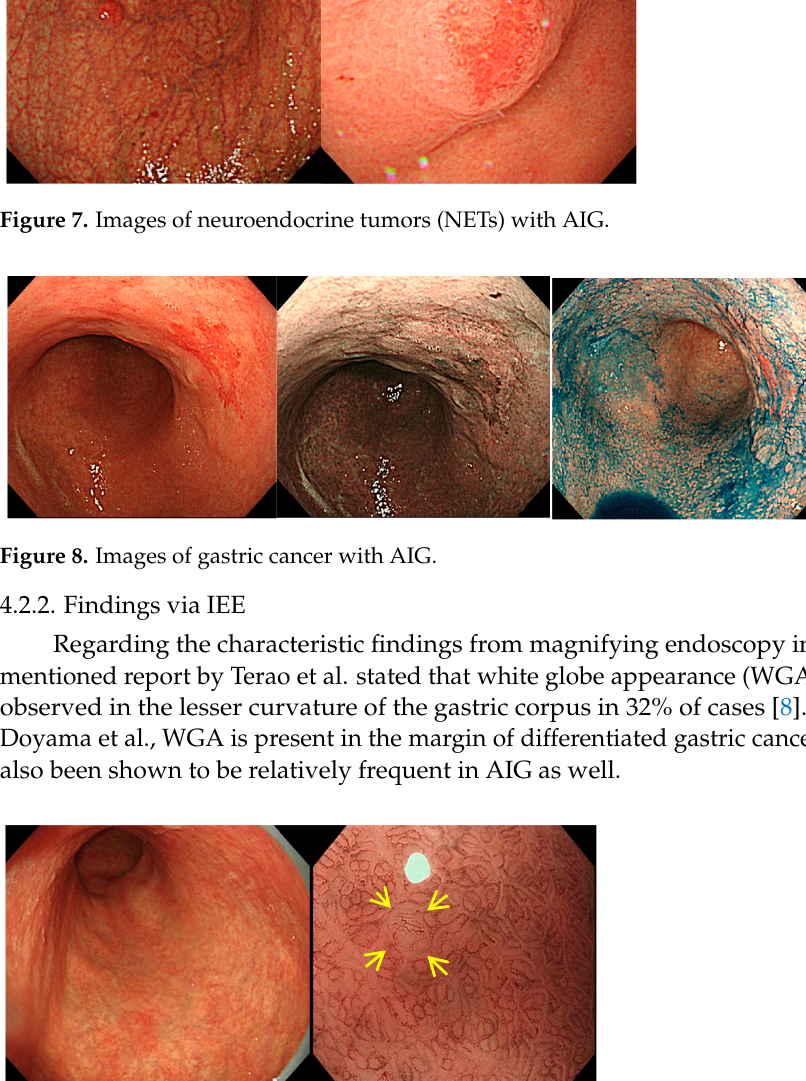
( d ) Figure 6. Images of antral mucosa with AIG: ( a ) normal mucosa; ( b ) patchy redness; ( c )/( d ) circular wrinkle ‐ like pattern (white light image/NBI image). Tumorous lesions associated with AIG include neuroendocrine tumors (NETs) and gastric cancer (Figures 7 and 8). The combination of these two lesions has long been es ‐ tablished. Prolonged hypergastrinemia causes an increase in enterochromatin ‐ like cells (ECL cells) in the fundic gland region, leading to the formation of endocrine cell mi ‐